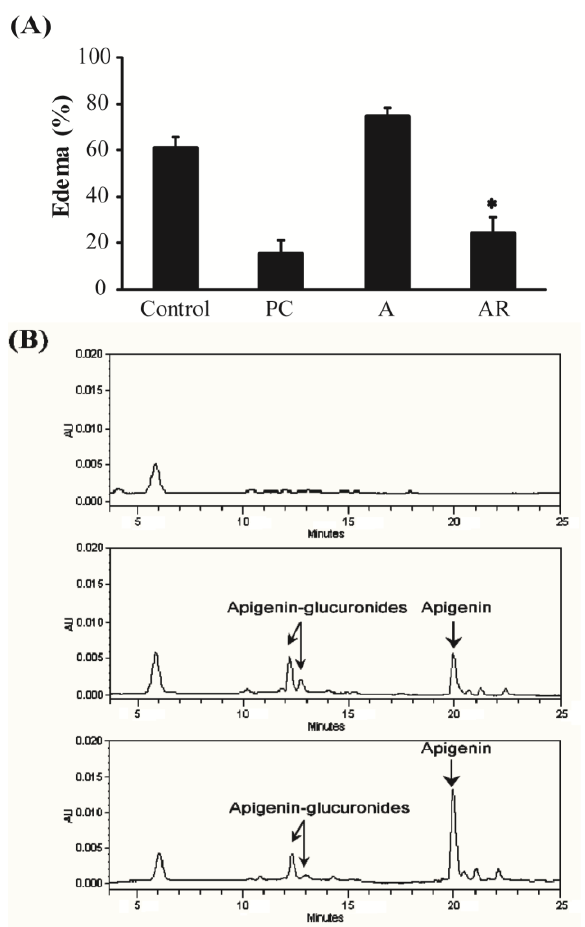
Figure 4. Effects of co-administration of apigenin and resveratrol on carrageenan-induced paw edema in mice. ( A ) Percentage of carrageen-induced paw edema of control group (vehicle), apigenin administered (50 mg/kg body weight), resveratrol administered (25 mg/kg body weight), apigenin and resveratrol administered (50 and 25 mg/kg body weight), and indomethacin (10 mg/kg body weight). Data were expressed as means ± SEM, n = 5. * p < 0.05 compared to administration of apigenin; ( B ) HPLC chromatograms of plasma of control (up), apigenin administered (middle), and apigenin and resveratrol co-administered (down) groups. Plasma samples were collected and analyzed for apigenin and its metabolites 5 h after carrageenan injection. Table 1. Mean concentration of apigenin in plasma after oral administration of apigenin and/or resveratrol to mice. Data were represented with mean ± SEM. ( n = 5).